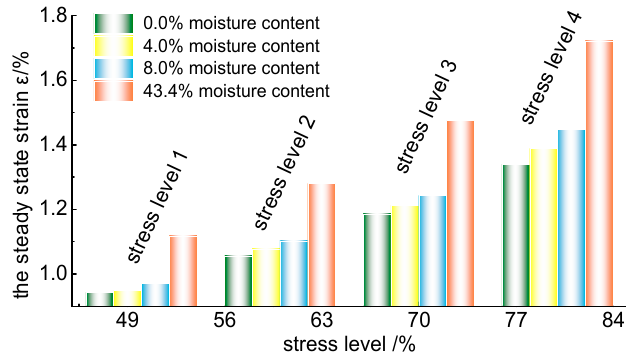
Figure 7. Steady ‐ state strain versus stress level and moisture content. Figure 7. Steady-state strain versus stress level and moisture